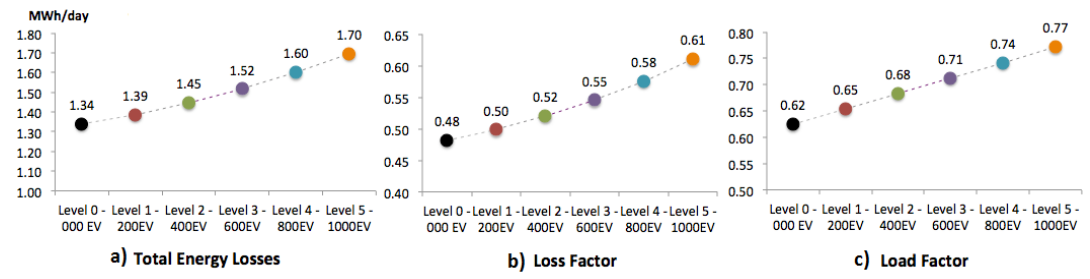
Figure 4. Off-peak load scenario: energy losses, loss and load factors by EV penetration level: ( a ) total energy losses; ( b ) loss factor; ( c ) load